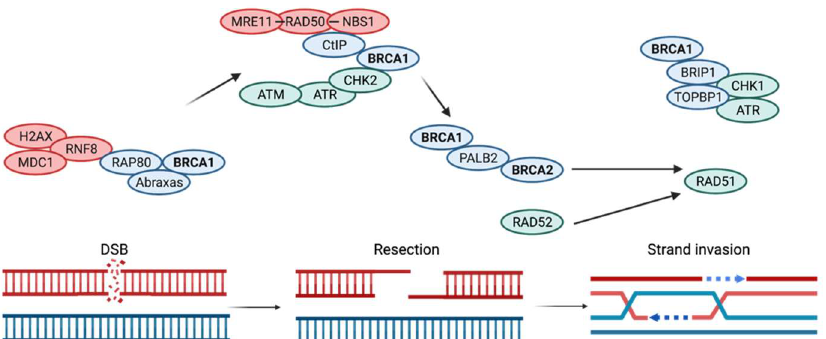
Figure 1. Molecular mechanisms involved in the double-stranded break repair by homologous recombination (HR).